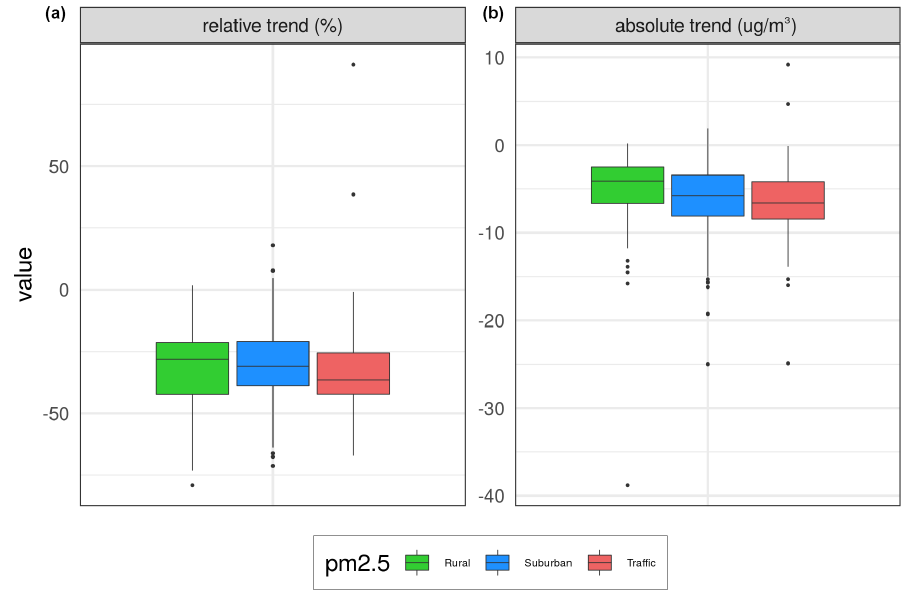
Figure 12. Box plots of changes in expected concentrations over the same three types of stations as in the map plots in Fig. 11. Panel (a) shows relative percent changes, while panel (b) shows absolute changes from 2005 to 2019 (units in % and µgm − 3 ).